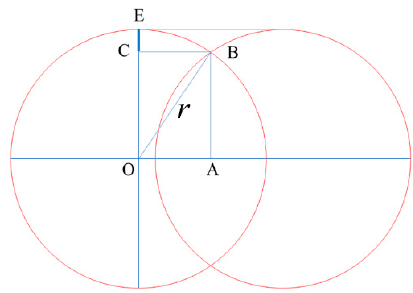
Figure 8. A schematic diagram showing the burrs dimension changing with the pulse overlap. As can be seen, the EC increases with the prolonging of OA .